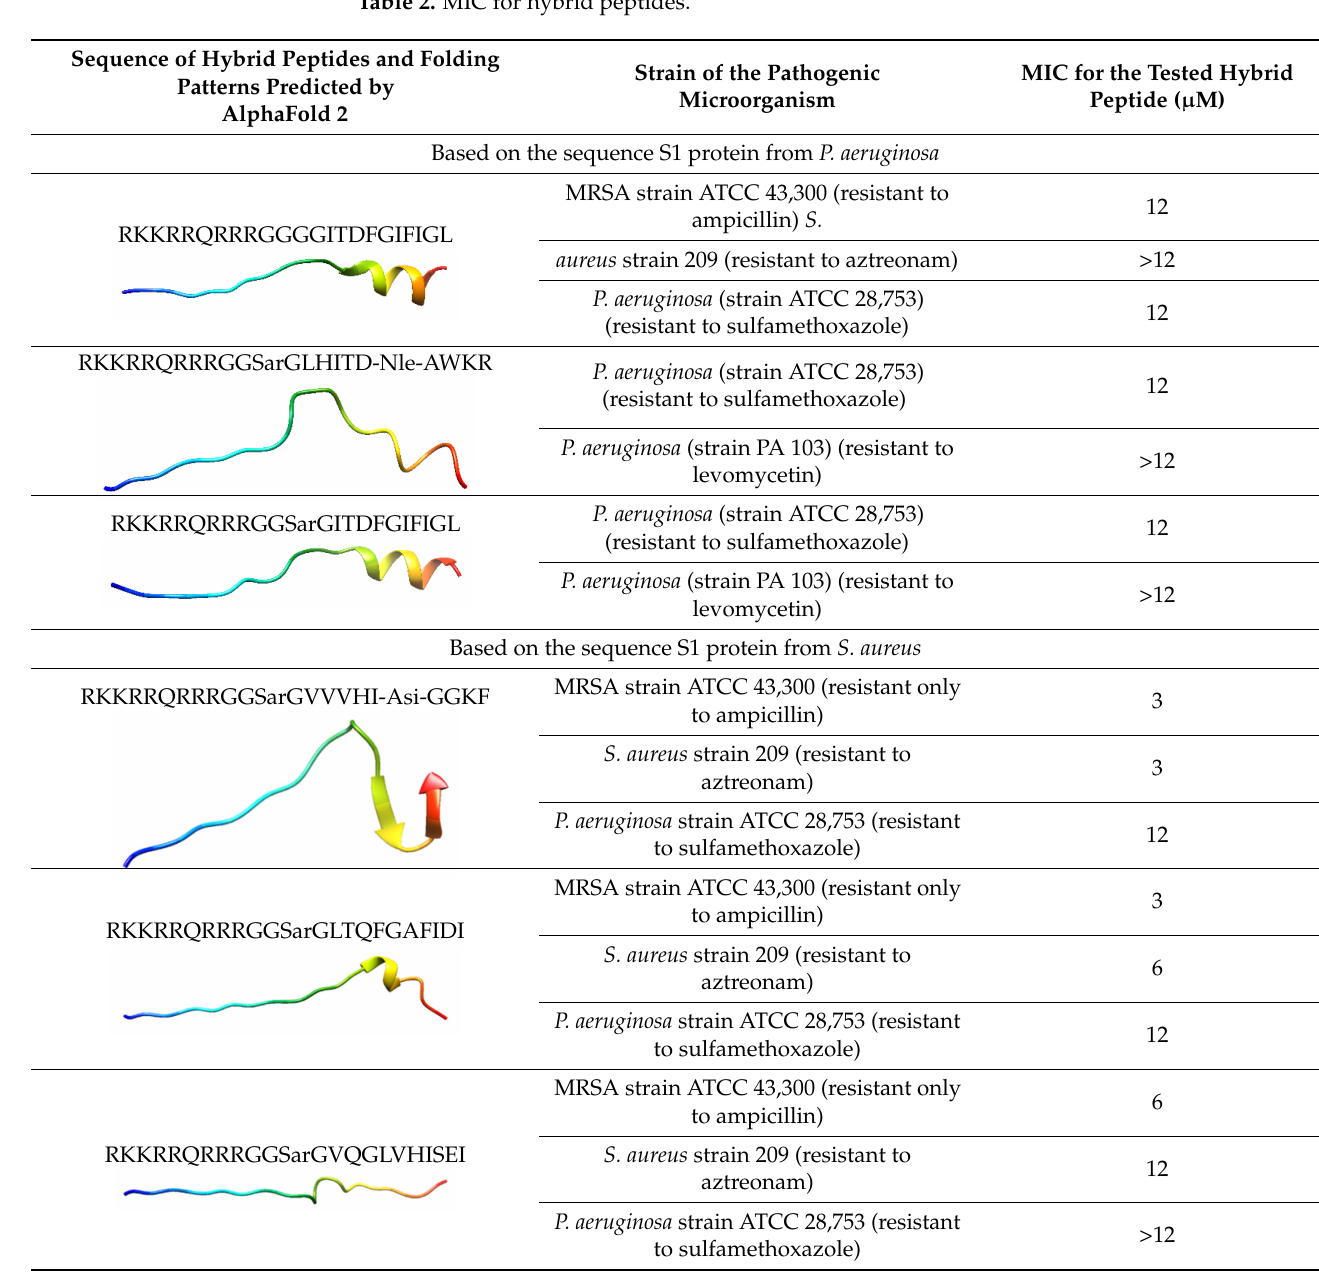
Table 2. MIC for hybrid